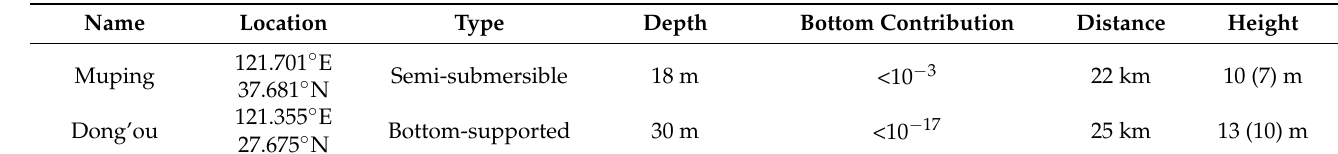
Table 1. Parameters of Muping and Dong’ou platforms. The height refers to SeaPRISM and roof of the platform (number in the parentheses) above the sea surface.